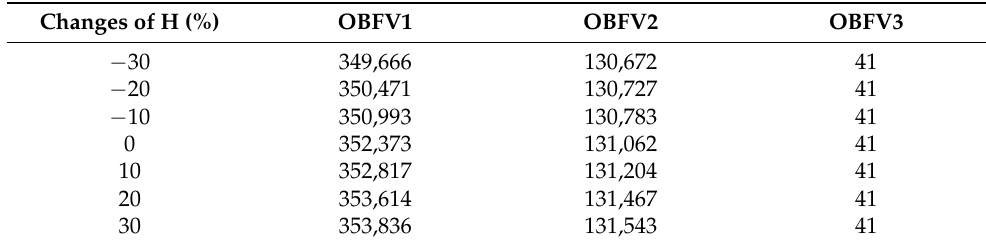
Table 7. OBFVs in changing effect of parameter